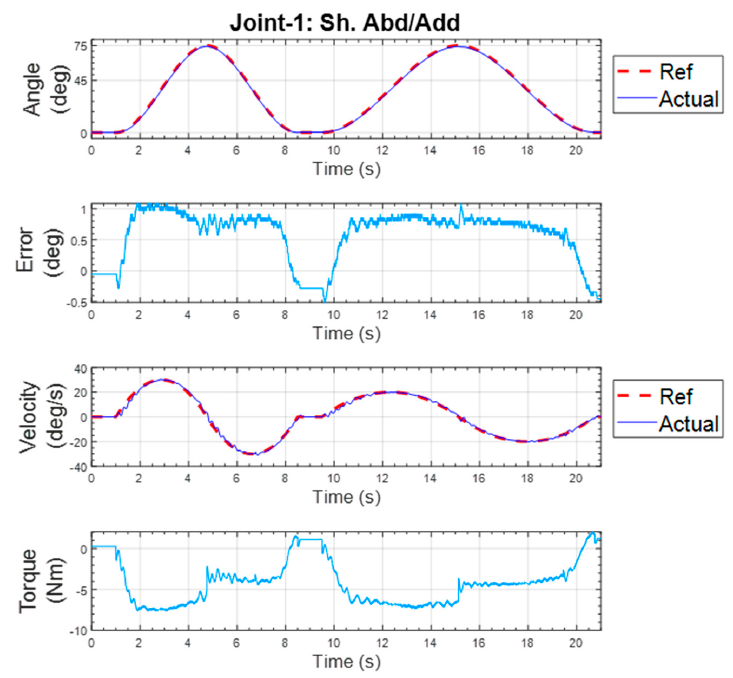
Figure 18. Individual joint exercise for shoulder abduction–adduction.